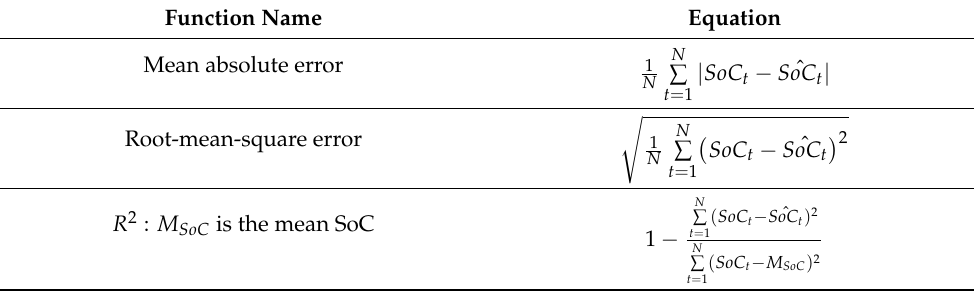
Table 4. Model’s metrics